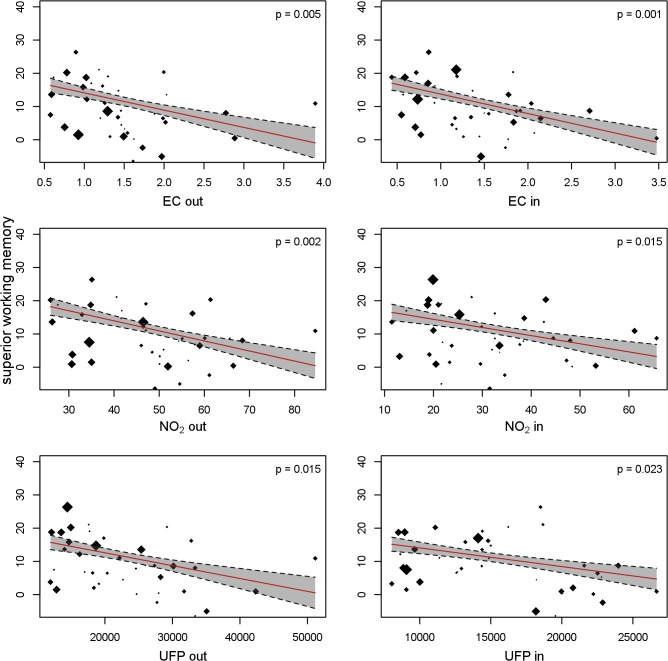
Superior working memory and long-term exposure to traffic-related air pollutants.Each dot depicts a school, with size proportional to the number of children. The cognitive development per school was estimated in a model with school and individual as random effects. The slope of the red line depicts the change in cognitive development as a function of the air pollutants, adjusted for age, sex, maternal education, residential neighborhood socioeconomic status, and air pollution exposure at home; school and individual as nested random effects in 2,715 children and 10,112 tests from 39 schools. Gray shading indicates 95% CI. out, outdoors (courtyard); in, indoors (classroom).